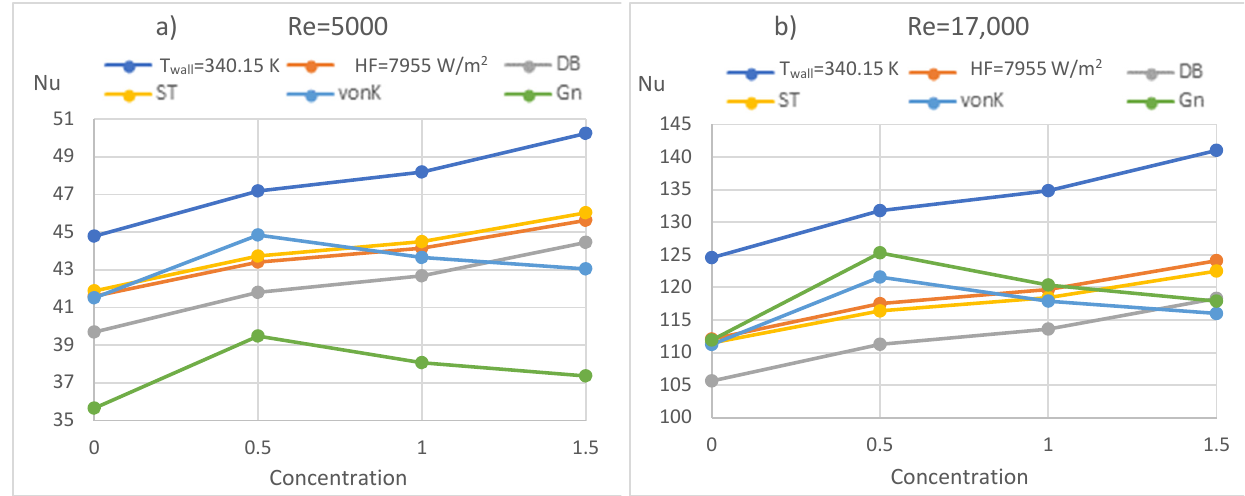
Figure 11. Comparison of the simulation results and correlations with ( a ) Re = 5000 ( b ) Re = 17,000.